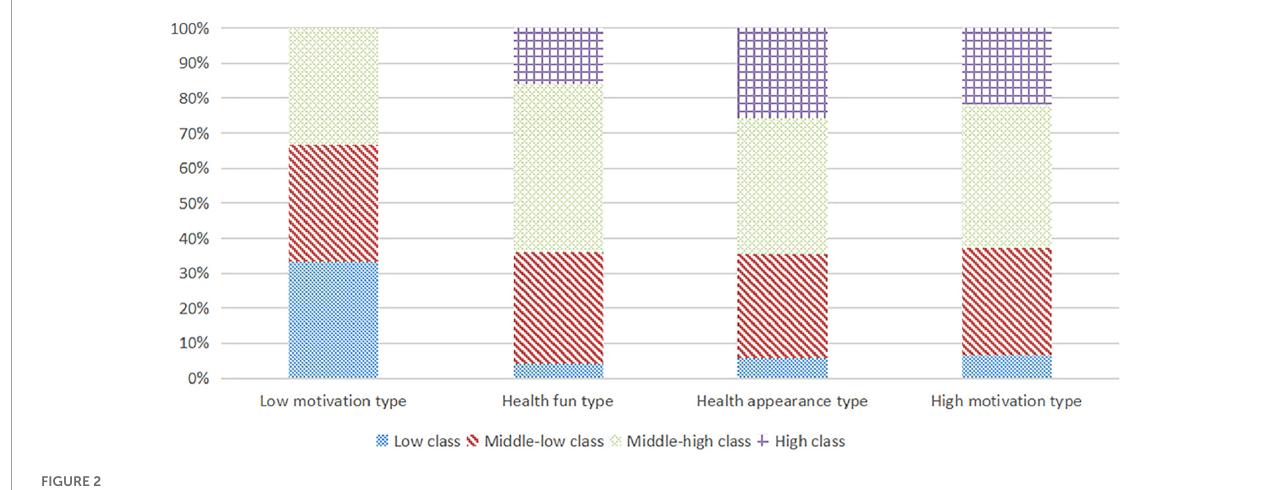
FIGURE2 Distribution of college students’ sports behavior motivation in different family social